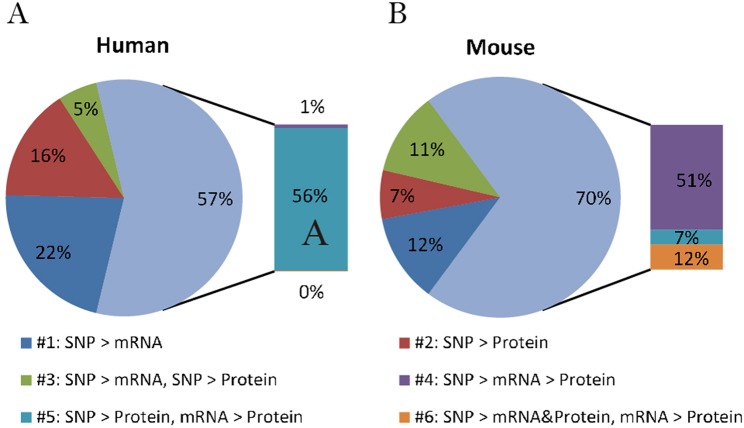
Distribution of genetic regulatory patterns. (A) Genetic regulatory patterns in human lymphoblastoid cell lines. (B) Local mouse regulation models according to Chick et al. (2016). This study identified the best local QTLs (±10 Mb of the gene midpoint) for each of the 6707 proteins in Diversity Outbred (DO) mice, and used Bayesian Information Criterion (BIC) to assess eight models between SNPs, mRNA, and protein. The six local regulation models associated with genetic variations were extracted to compare with those in humans.